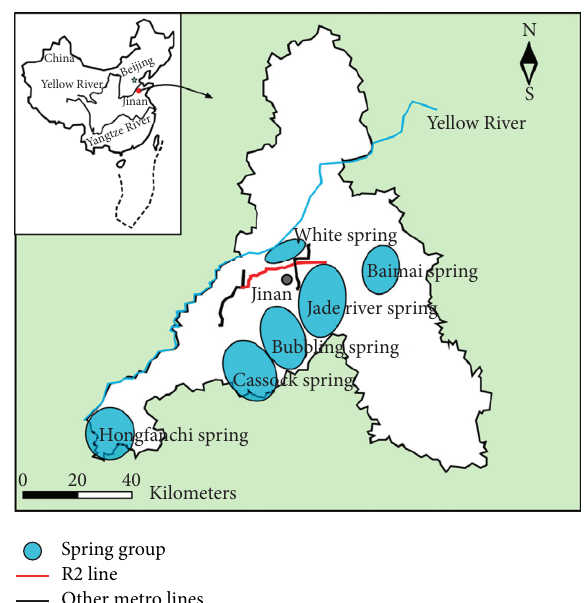
Figure 1: Location and general layout of Jinan Metro lines and distribution of the main spring